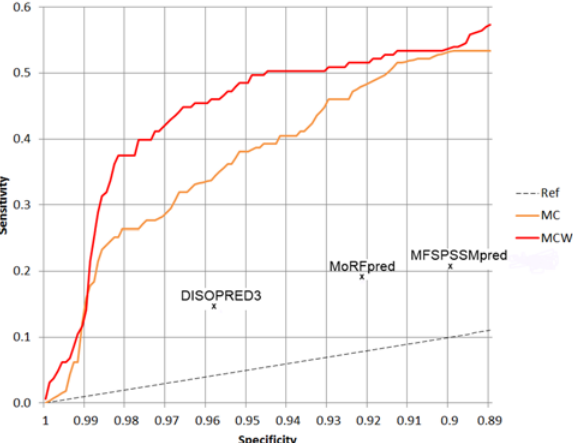
Fig 4. Comparing the performance of MoRF CHiBi_Web (MCW in red), MoRF CHiBi (MC in orange), DISOPRED3, MFSPSSMpred and MoRFpred using EXP9. Curves of sensitivity as a function of specificity for MoRF CHiBi_Web and MoRF CHiBi are computed on a set of 9 protein sequences collected by Jones and Cozzetto [15]. The data points for each of the three predictors, DISOPRED3, MFSPSSMpred and MoRFpred, are from published results of Jones and Cozzetto